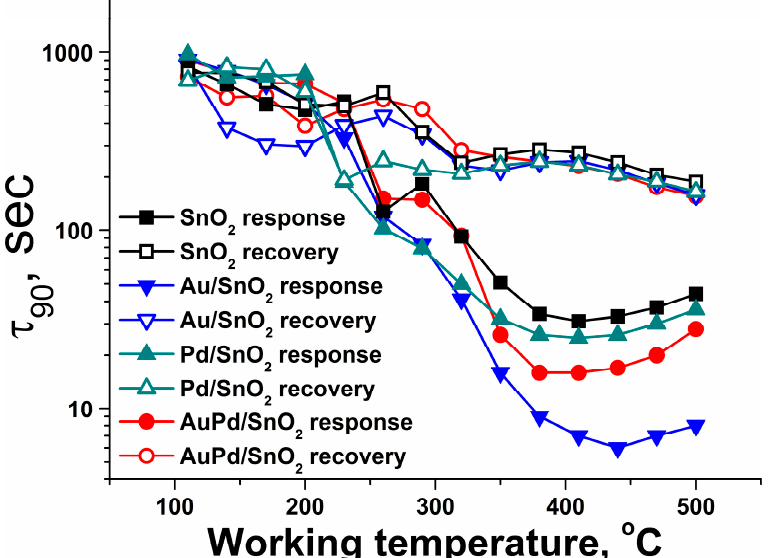
Figure 10. Times of response and recovery for synthesized materials during detection of C3H8 50 ppm in dry